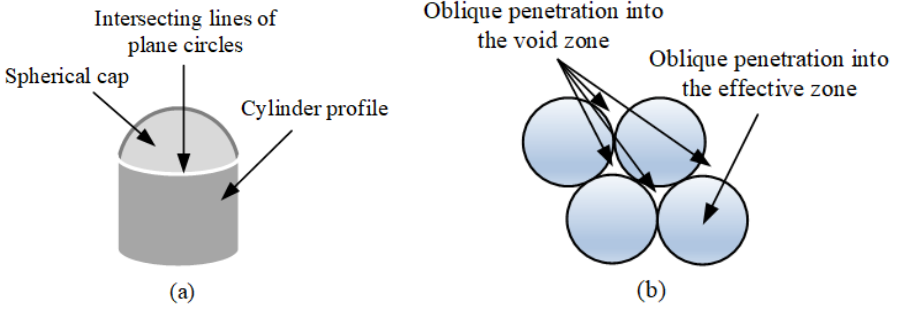
Figure 1. Schematic diagram of ( a ) the “projectile monomer” and ( b ) its combination.